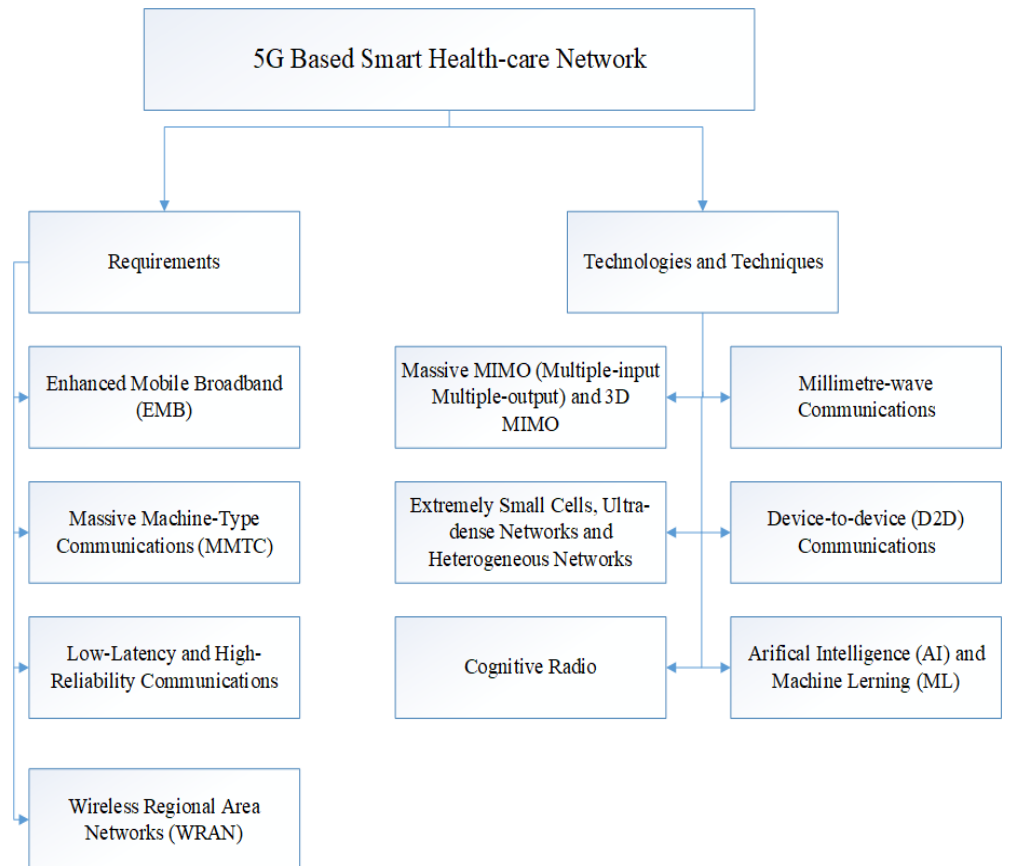
Figure 5. Requirements and technologies trend of 5G based smart